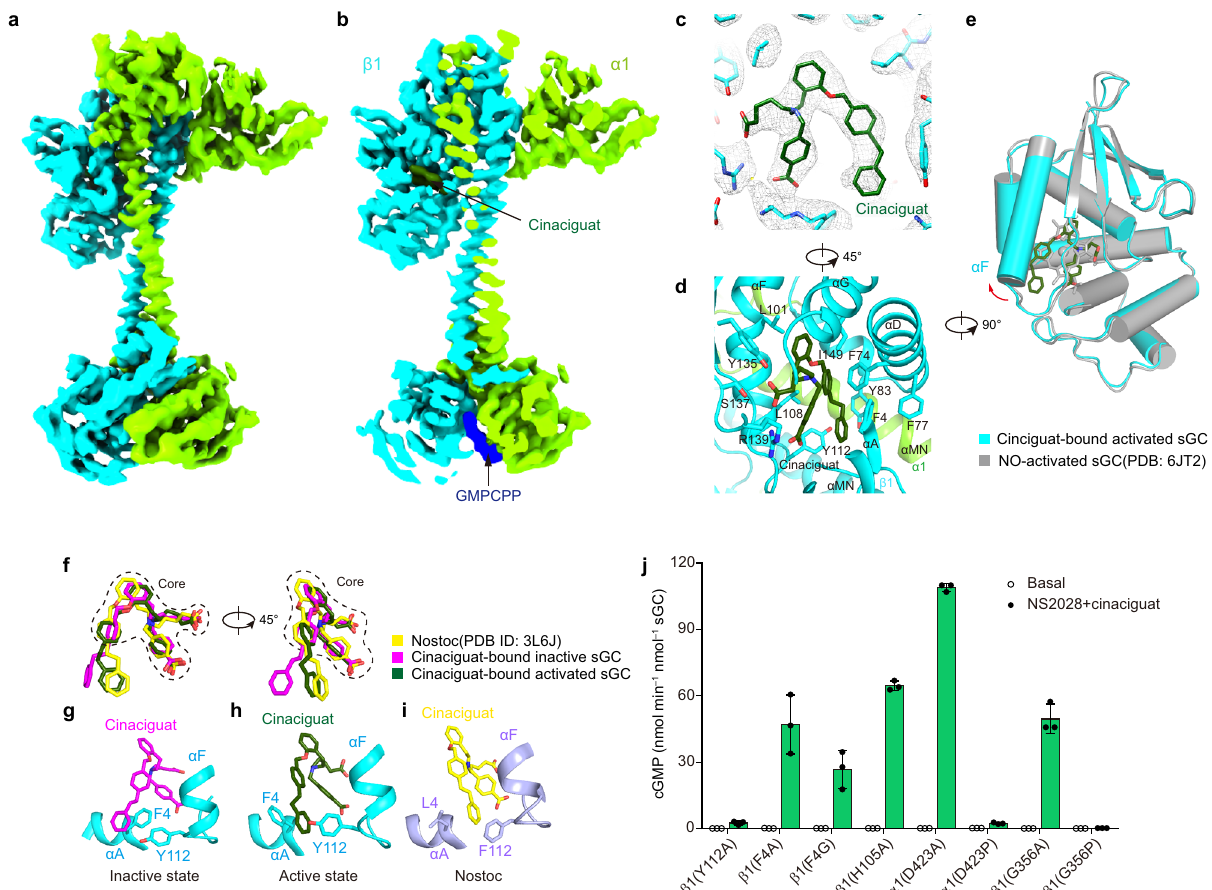
Fig. 4 Structure of sGC in the cinaciguat-bound activated state. a Cryo-EM map of sGC in the cinaciguat-bound activated state (CA) state. The density of cinaciguat is shown in green. b The cut-open view of ( a ). c Density at the cinaciguat-binding site in CA state. Cinaciguat is shown as dark green sticks. d The interactions between cinaciguat and sGC. A 45° rotated view compared to ( b ). e Structure comparison of sGC β 1 H-NOX in the CA state (colored) and the NO-activated state (gray). f Structural comparison of cinaciguat in the Nostoc H-NOX domain (PDB ID: 3L6J, yellow), CI state (magenta) and CA state (green). The core of cinaciguat is indicated by dashes. g The interactions between the terminal benzyl group of cinaciguat and F4 and Y112 of sGC in the CI state. h The interactions between the terminal benzyl group of cinaciguat and F4 and Y112 of sGC in the CA state. i The interaction between the terminal benzyl group of cinaciguat and L4 and F112 of the Nostoc H-NOX domain (PDB ID: 3L6J). j End-point activity assay of the various sGC mutants in the presence or absence of 20 mM NS2028 and 20 mM cinaciguat as indicated. Mean ± s.d., n = 3 biologically independent reactions. Source data are provided as a Source Data fi